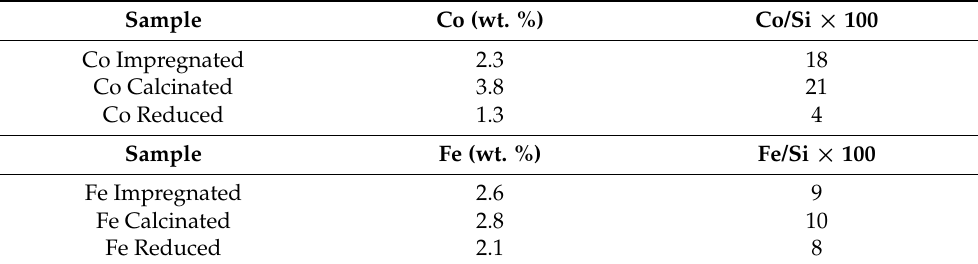
Table 2. Co and Fe content and Me2p/Si2p ratio.